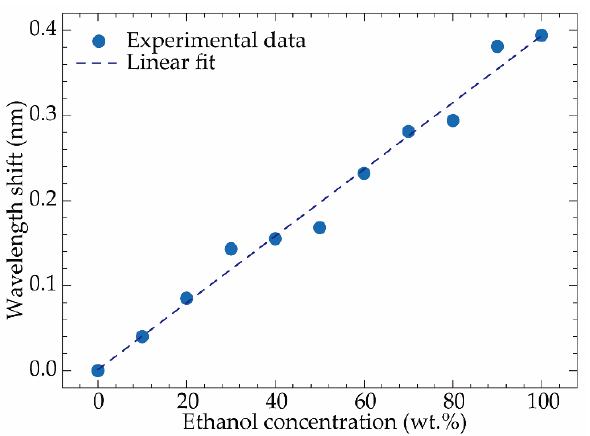
Figure 5. Sensor wavelength shift for different concentrations of ethanol. The blue circles represent the experimental data, and the dashed blue line represents the applied linear fit.